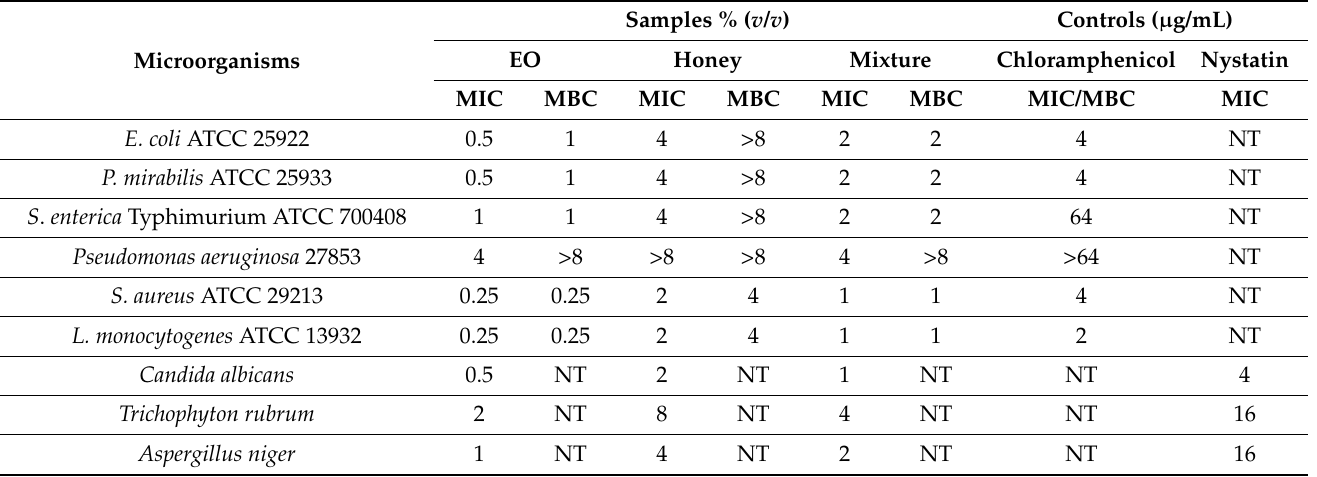
Table 8. MIC and MBC of MCEO, M. chamomilla honey, and their mixture in percentages ( v / v ). Samples % ( v / v ) Controls ( µ g/mL) EO Honey Microorganisms